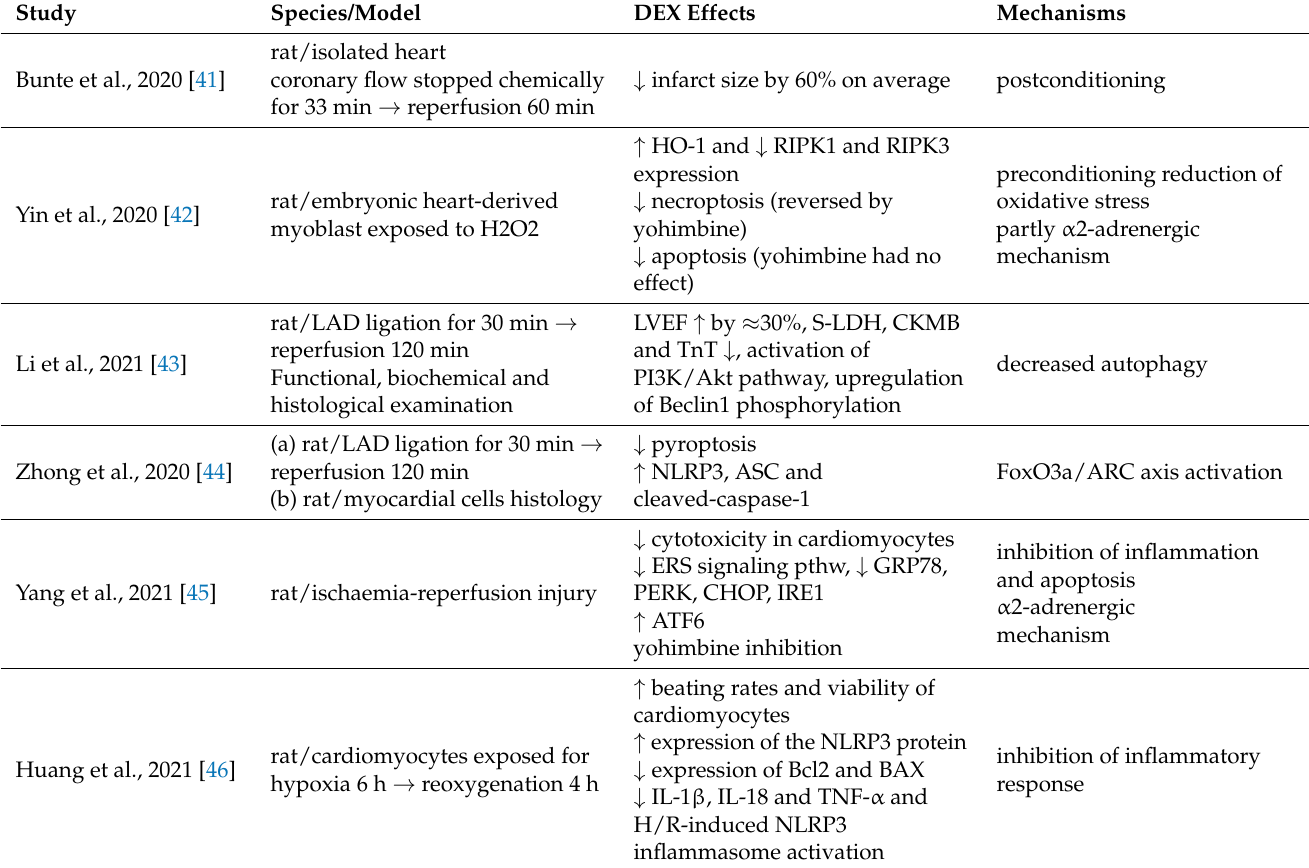
Table 2. Summary of controlled experimental studies on the effects of DEX on myocardial